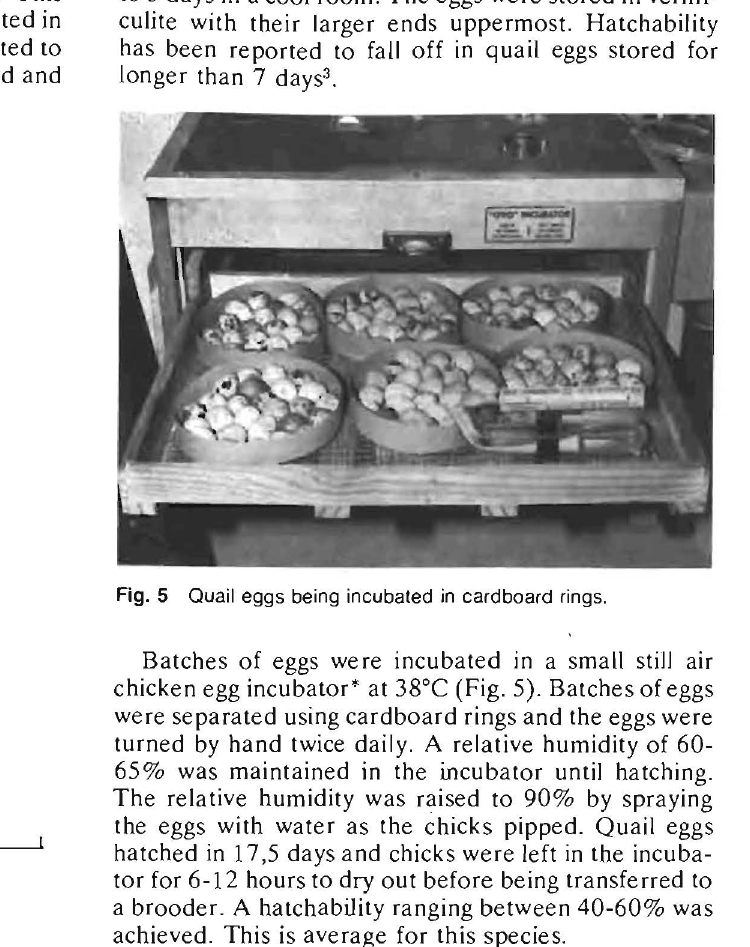
Fig. 4 Growth rate of Coturnix quail.